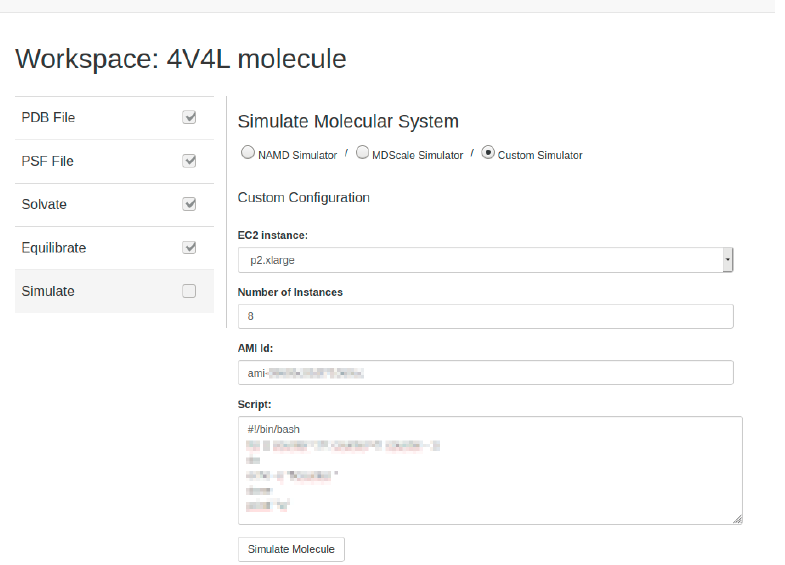
Figure 12. Setting up a custom MD simulation. Users can provide a custom AMI, the type and number of instances, and an execution